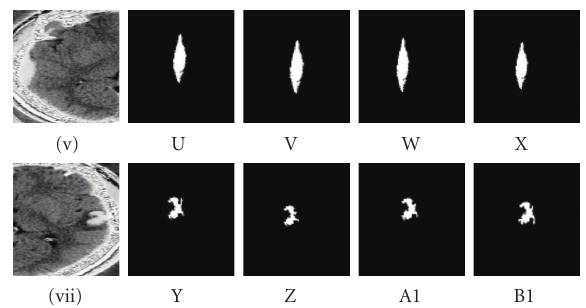
Figure 2: (U, Y) distance = 4, lower = 150, upper = 175, (V, Z) distance = 5, lower = 155, upper = 185, (W, A1) distance = 6, lower = 160, upper = 195, (X, B1) distance = 7, lower = 175, upper = 205 are (vi) values set for the subdural haematoma and (vii) contrecoup contusion by threshold approach.